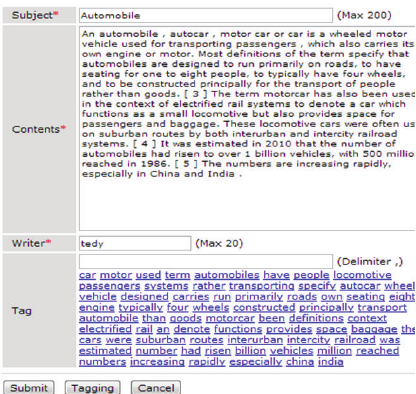
Figure 6: User input screen (tags that are extracted automatically are shown in this screen).